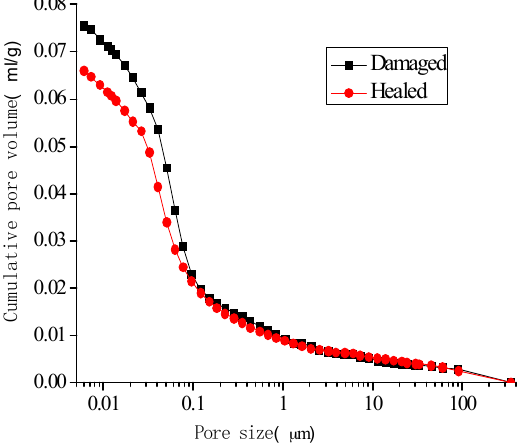
Figure 17. Cumulative-pore volume distribution for specimens with 9% microcapsules.